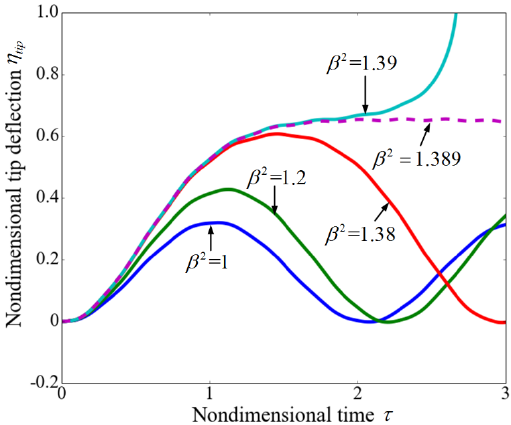
Figure 11. Tip displacement time history of the cantilever for various voltages when the flow velocity equals zero.